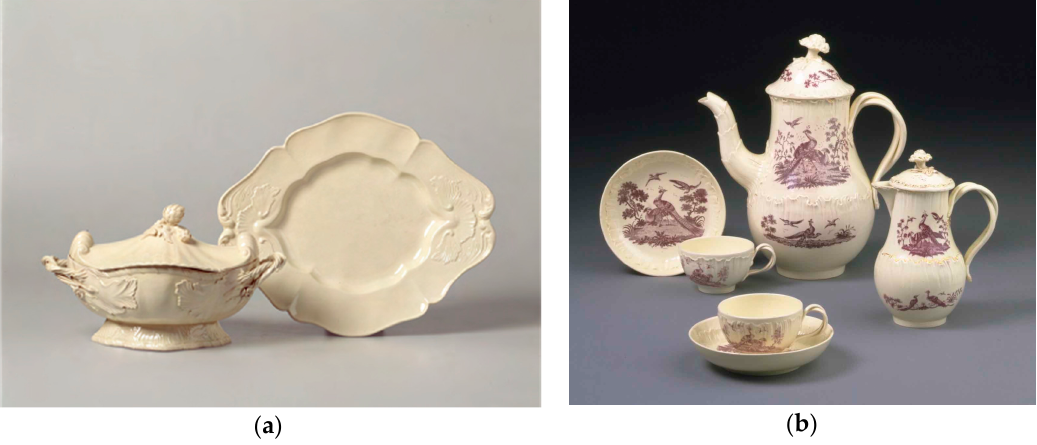
Figure 2. English white earthenware . ( a ) Tureen with supporting plate. Wedgwood Queen’s ware , Etruria manufactory, ca. 1770. Tureen H: 20.5 cm, L: 36 cm. Plate L: 43 cm. Photo Jacques Pugin. © Musée Ariana, Switzerland; ( b ) Queen’s ware service, on-glaze transfer-printed with purple pigments. Josiah Wedgwood and Sons Ltd. (Etruria, Stoke-on-Trent, UK), printed in Liverpool by Guy Green, ca. 1775. Reg. No. 414:1157/B&C-1885. © Victoria and Albert Museum, London.